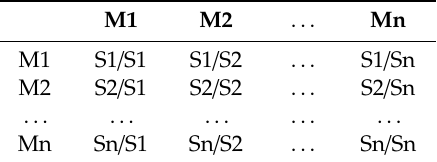
Table 7. Relative value-based weight.